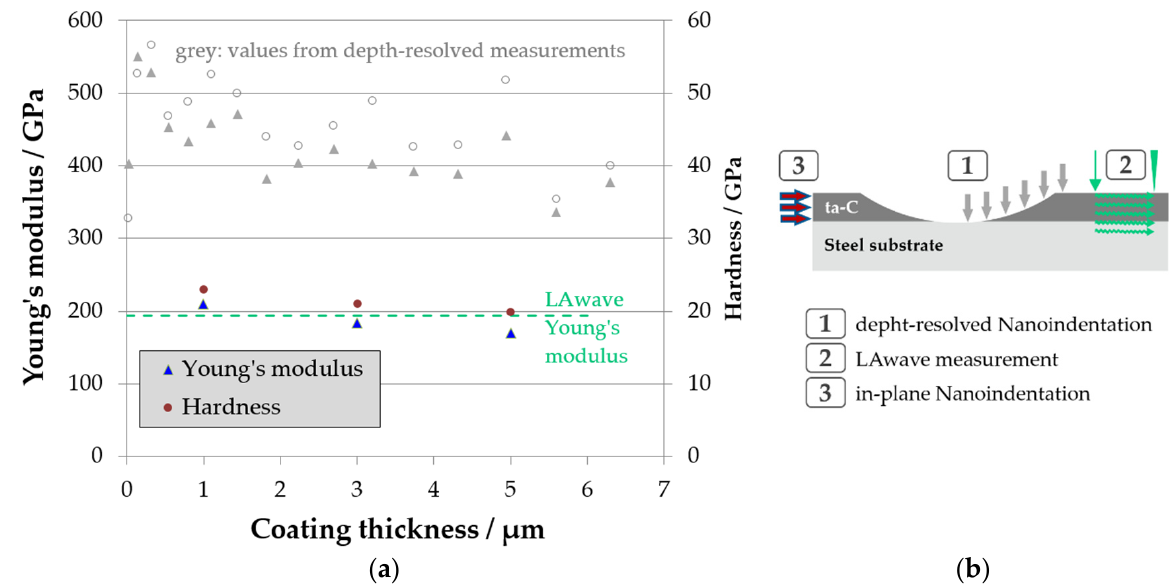
Figure 7. ( a ): in-plane Young’s modulus and hardness values measured by nanoindentation in coating D on a prepared cross-section. The values obtained by conventional, depth-resolved hardness measurement are included for illustration (grey symbols). The Young’s modulus value as measured by LAwave is added for comparison (dashed green line). ( b ): schematic illustration of the measuring directions of the different measuring techniques.